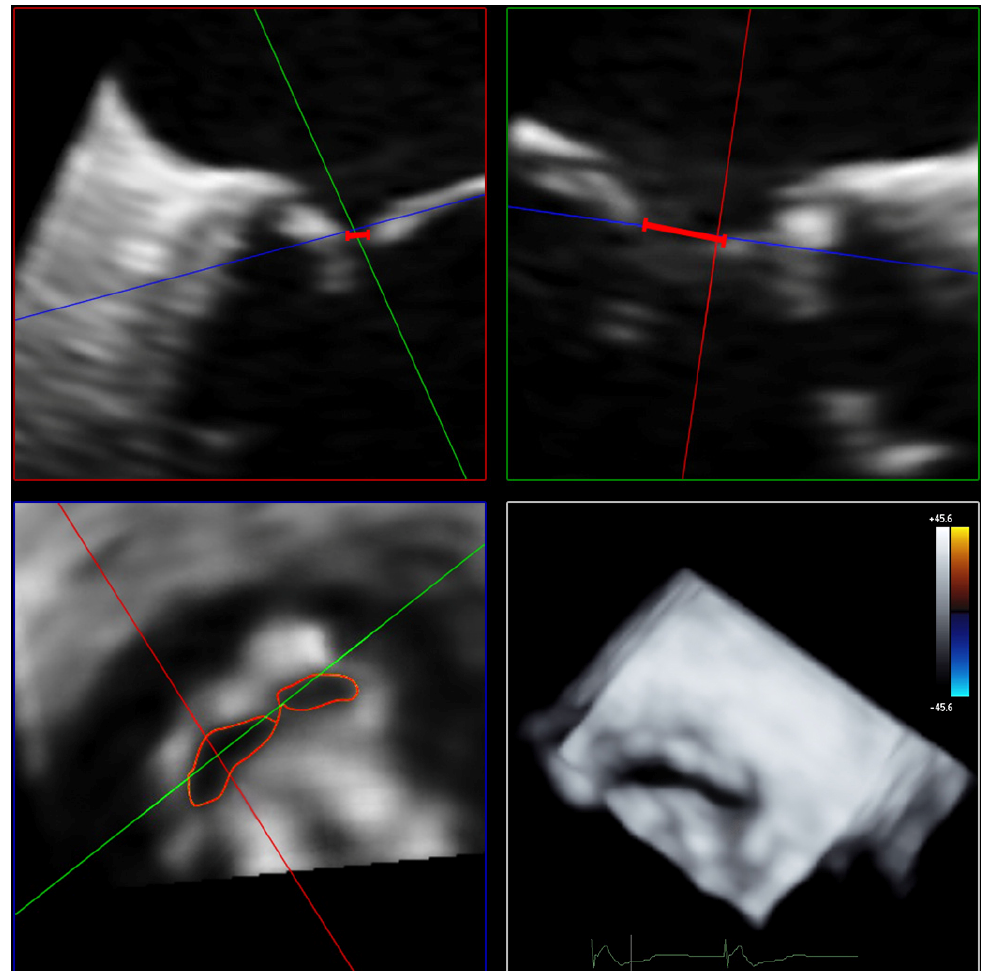
Figure 4. Determination of AROA using multiplanar reconstruction of the 3D color Doppler dataset without color. Echocardiographic images with 3 slice planes and 3D reconstruction ( lower right ) of the 3D color Doppler dataset (mid-systolic) with subtraction of color. Planimetric fi tt ing of the 2 upper planes along the course of the color Doppler jet; third plane ( lower left ) adjustment orthogonal to planes along the jet. Then, subtraction of color and fi nding the minimum coaptation defect between the mitral valve lea fl ets using translation and tilting of the third plane; manual measurement of the minimum coaptation defect using outlining. Abbreviations: AROA = anatomical regurgitation ori fi ce area; 3D = three-dimensional.